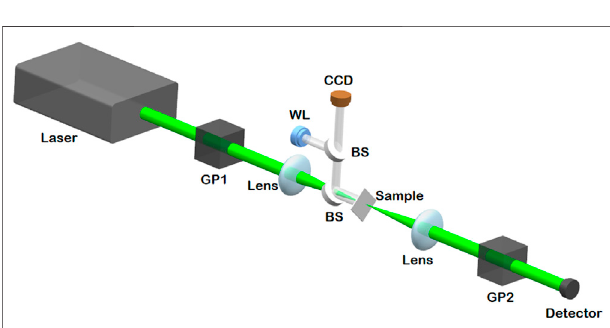
FIGURE 2 | Schematic diagram of the measurement of the retardance. GP 1 isthepolarizerand GP 2 istheanalyzer, BSisthebeam splitter,and WLis the white light